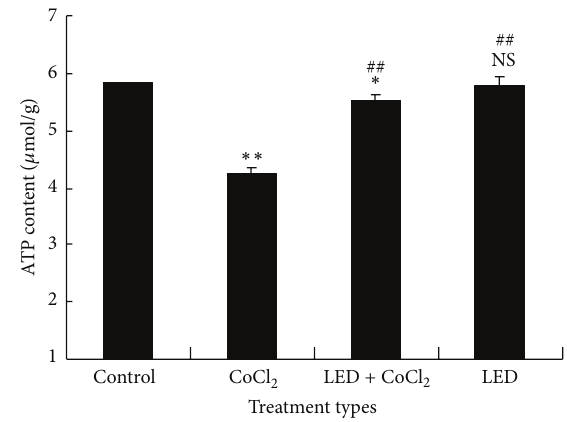
Figure 5: Effect of 25 mW/cm 2 808nm LED light pretreatment on cellular ATP content. After the lytic neuron cells were placed on ice and centrifuged for 8min, its supernatant was collected. After treatment and putting at 37 ∘ C for 30 minutes, protein concentration of each sample was calculated. After 100 𝜇 L ATP testing reagent was added into the testing wells and put at room temperature for 3– 5 min, ATP content was calculated. Data are Means ± SEM. ∗∗ ( 𝑃 < 0.01 ) and ∗ ( 𝑃 < 0.05 ) mean compared with control group and ## ( 𝑃 < 0.01 ) and # ( 𝑃 < 0.05 ) mean compared with 100 𝜇 M/L- CoCl 2